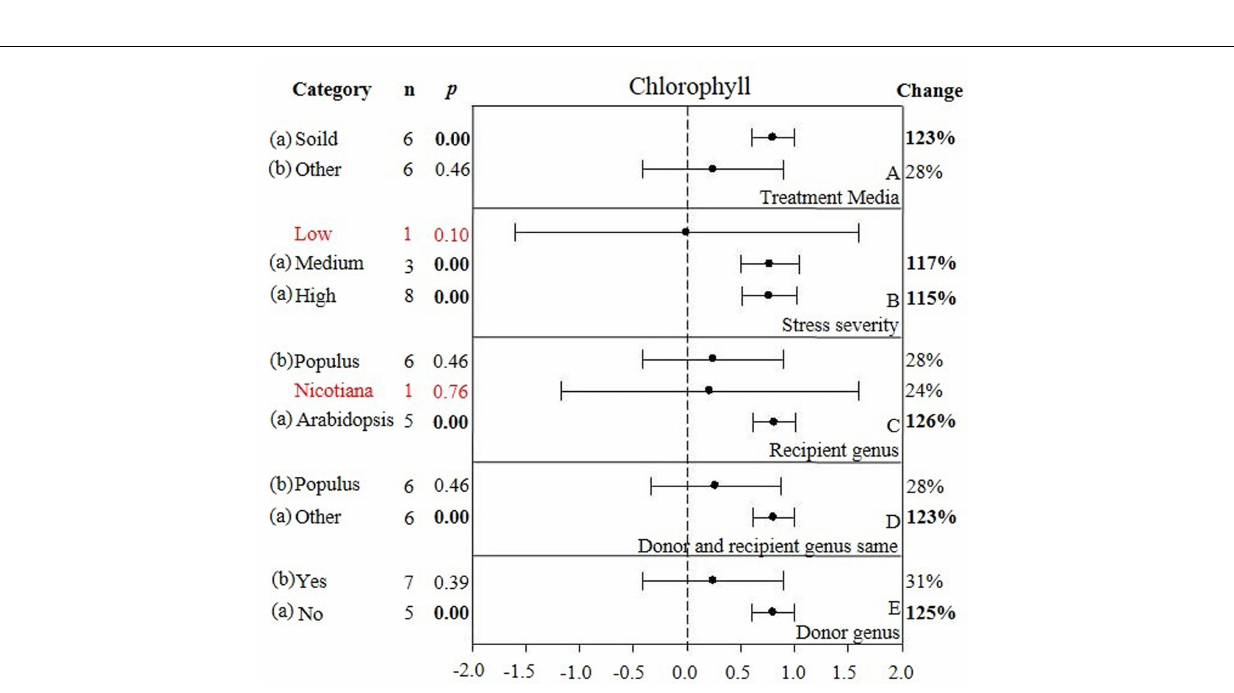
FIGURE 4 | Weighted summary effect sizes (ln R ) and 95% CIs showing how moderator variables affect the extent to which CIPK transformation modifies seed germination. (A) Duration of exposure to NaCl, (B) Stress severity, (C) Donor and recipient genus same, (D) Recipient genus, (E) Donor type, and (F) Donor genus. A p ≤ 0.05 indicates that the moderator level was significantly different than zero; n stands for the number of studies.